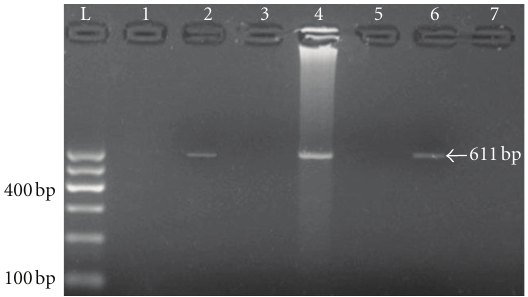
Figure 4: PCR amplified OmtBII sequence (611bp) in three A. parasiticus isolates obtained in this study. Lane L indicates the 100 base pair ladder, Lane 1 represents PCR negative control, Lane 2, 4, and 6 represent three A. parasiticus isolates, and lanes 3, 5, and 7 represent the three A. flavus isolates. Electrophoresis was performed on 1.5% agarose gel and run with 3volt cm − 1